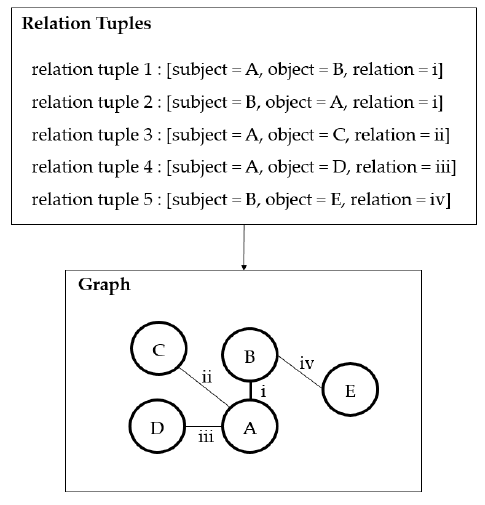
Figure 4. Adding edge interactions between